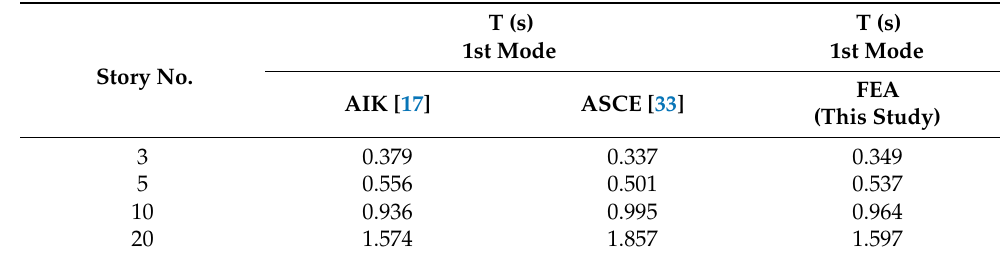
Table 2. Dynamic characteristics of the building frames.